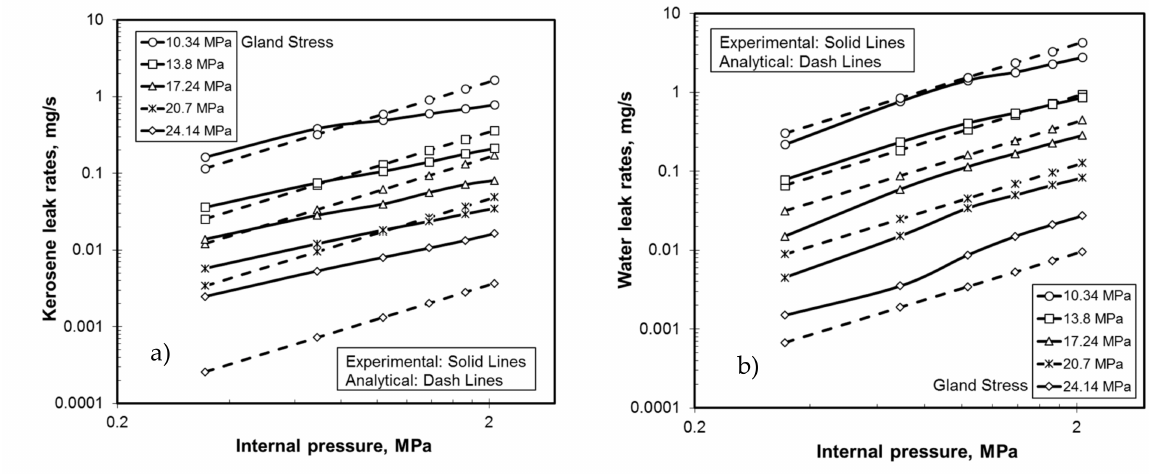
Figure 9. Leak rate predictions in die rings ( a ) water ( b )